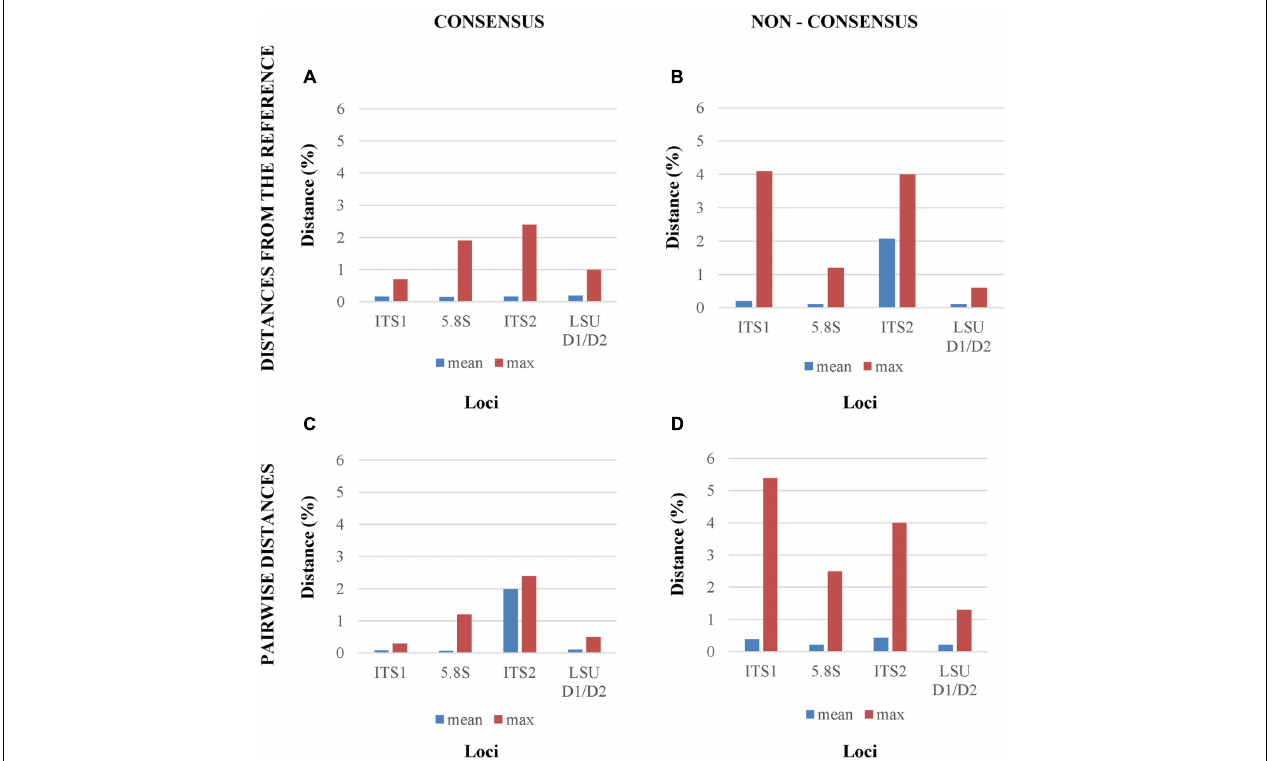
FIGURE 3 | Mean and maximum distances from reference Sanger sequence of four different analytical settings. The four panels report the distances between, (A) the reference Sanger Sequence and the cloned consensus sequences; (B) the reference Sanger Sequence and the original (non-consensus) cloned sequences; (C) and (D) all the pairwise distances among the consensus and the original sequences, respectively.